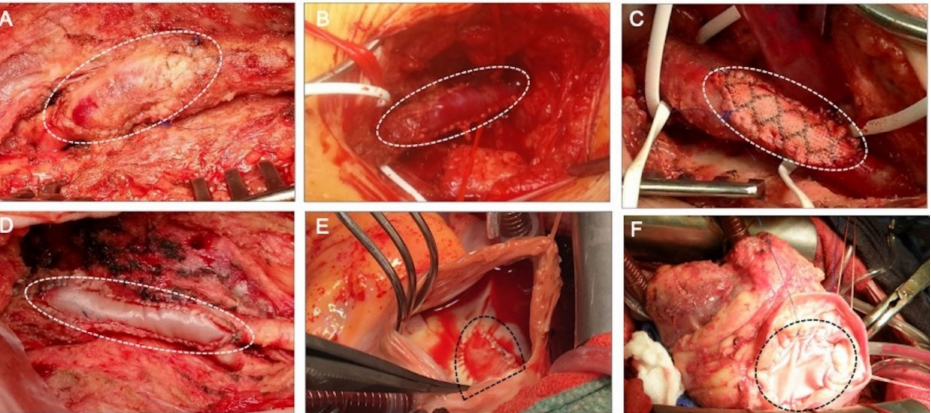
Figure 1. Clinically implanted materials for patch angioplasty. ( A ) Autologous arterial patch used for arteriotomy closure after an endarterectomy of the common and profunda femoral arteries. The patch was created through the harvesting and desobliterating of a chronically occluded superficial femoral artery. ( B ) Autovenous patch created from a saphenous vein graft used for repair of a stenotic distal anastomosis of a femoral–popliteal bypass graft on the popliteal artery. ( C ) Synthetic prosthetic patch made of polyethylene terephthalate (PET) used for patch repair of a stenotic common femoral artery. ( D ) Biologic patch angioplasty of a common femoral artery bifurcation carried out with a xenograft glutaraldehyde-treated bovine pericardium (XenoSure ® ). ( E ) Patch closure of a cardiac interatrial septal defect with an autologous pericardium intraoperatively fixed with formaldehyde. ( F ) Patch closure of a cardiac interventricular septal defect with a xenograft glutaraldehyde-fixed bovine pericardium treated with a proprietary anti-calcification procedure (SJM ® Pericardial patch with EnCap ® Technology). The patches are marked with dotted